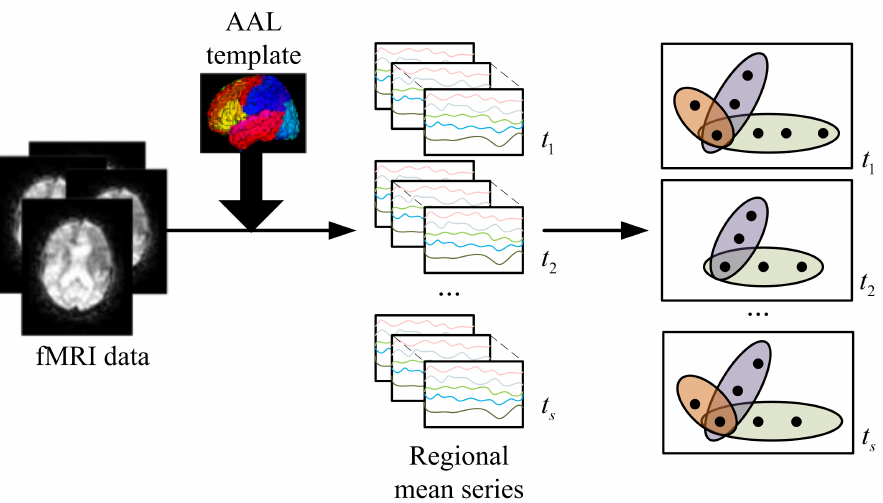
Figure 1. The construction of the dynamic hyperbrain network. (The fMRI image is matched with the AAL template to obtain the time-varying signal of each brain region. Then, the signal is divided into s time periods, and the sparse representation is calculated, respectively, to obtain the hyperbrain network of s time